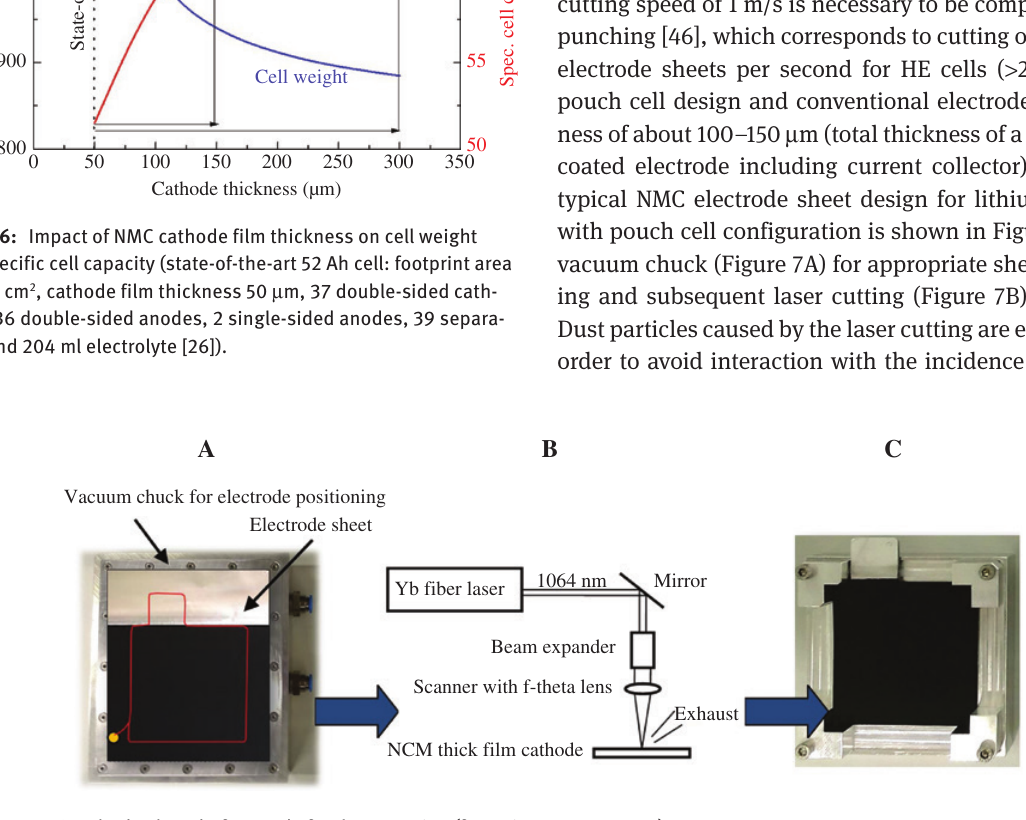
Figure 7: NMC cathode sheet before and after laser cutting (footprint area 8 × 8 cm 2 ). (A) vacuum chuck and electrode sheet. The red line describes the desired electrode contour; (B) schematic view of laser cutting of electrode sheets using scanner optics; (C) laser-cut electrode sheet in a storage box for subsequent assembly